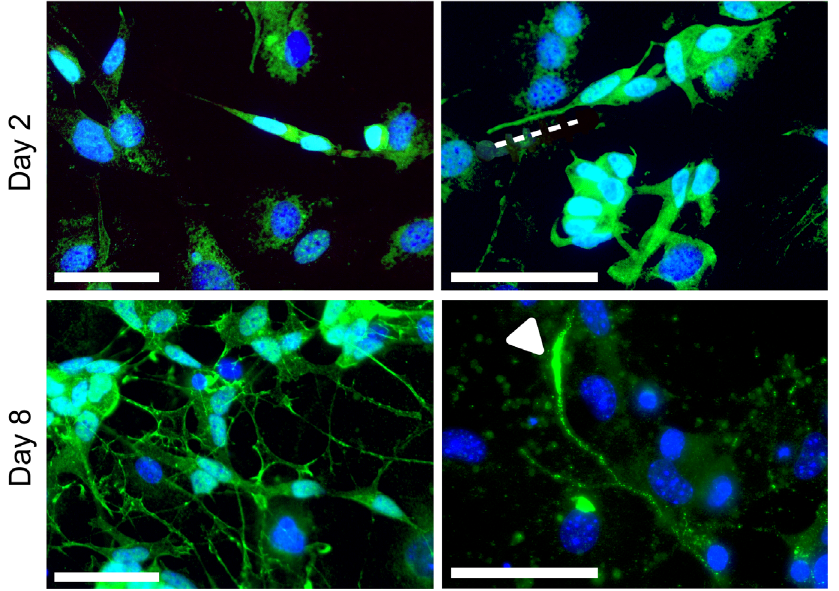
Fig 7. Differentiation of SH-SY5Ycells expressing HA tagged mouse angiogenin on PA6. (a-b) SH-SY5Y on PA6 on Day 2 continue to show uniform expression in cytoplasm and neurite. (c-d) By day eight expression is reduced at the base of the neurite, but greatly increased at the tip.Scale bar (50 μ